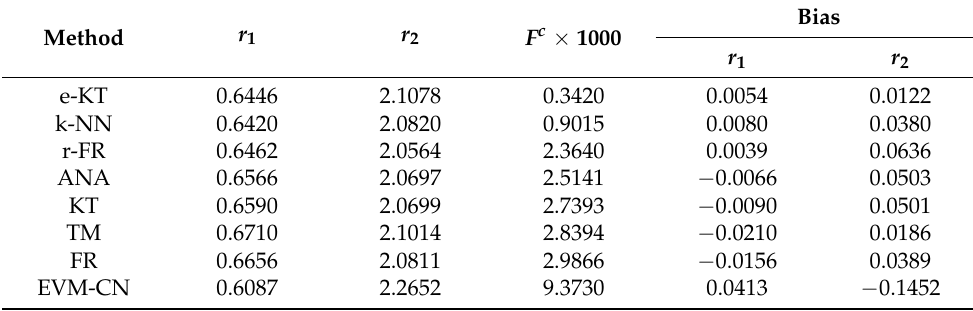
Table 14. Reactivity ratios obtained in the imposed conditions of LC3.